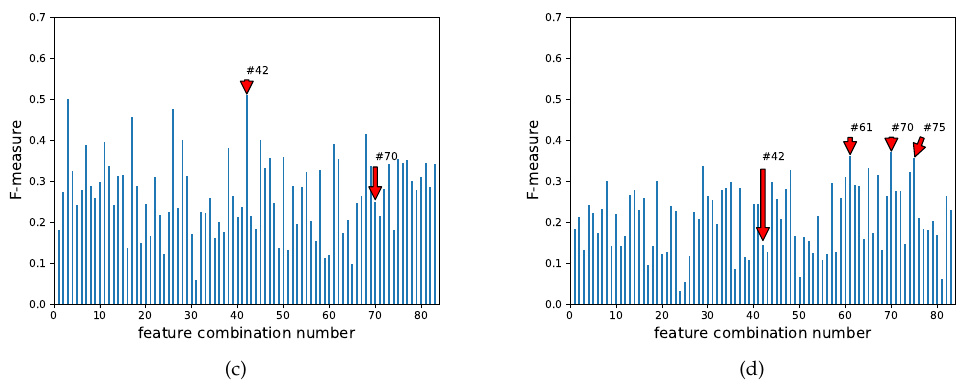
Figure 7. F-measure for each feature combination in classes A, B, C, and D. ( a ) Class A, ( b ) Class B, ( c ) Class C, ( d ) Class